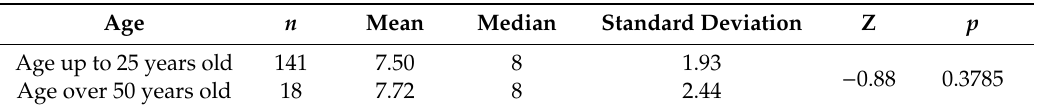
Table 15. The level of intensity of the motivation to participate in the Poznan Half Marathon in the future—depending on